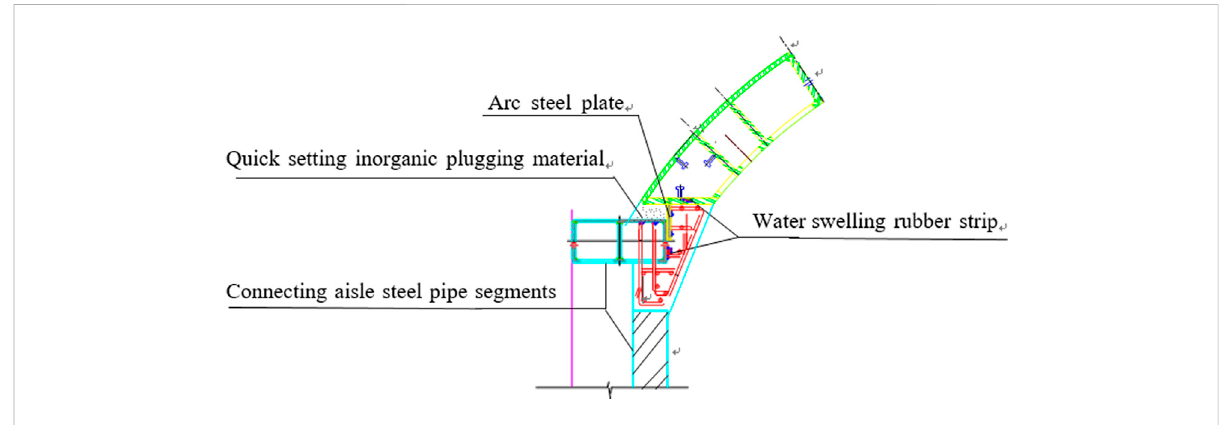
FIGURE 3 Waterproof structure of a special segment lining joint.